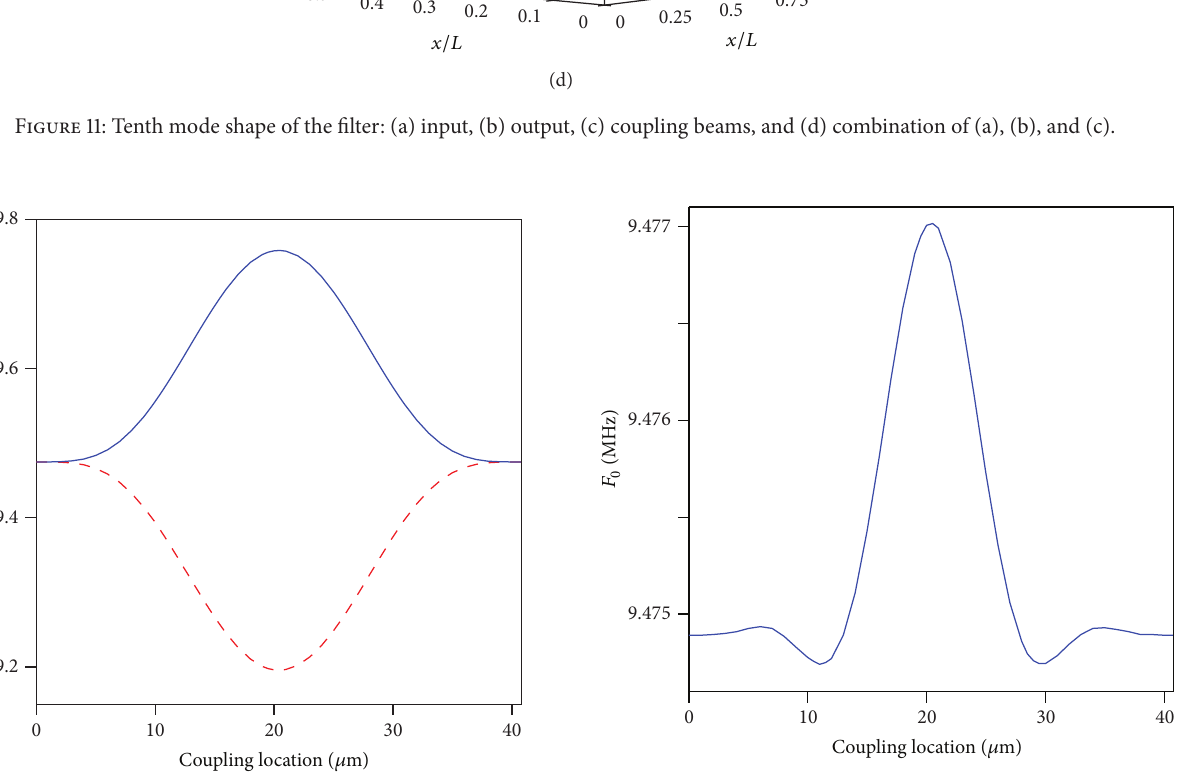
Figure 12: Variation of the first (dashed line) and second (solid line) natural frequencies of the filter with the attachment location.